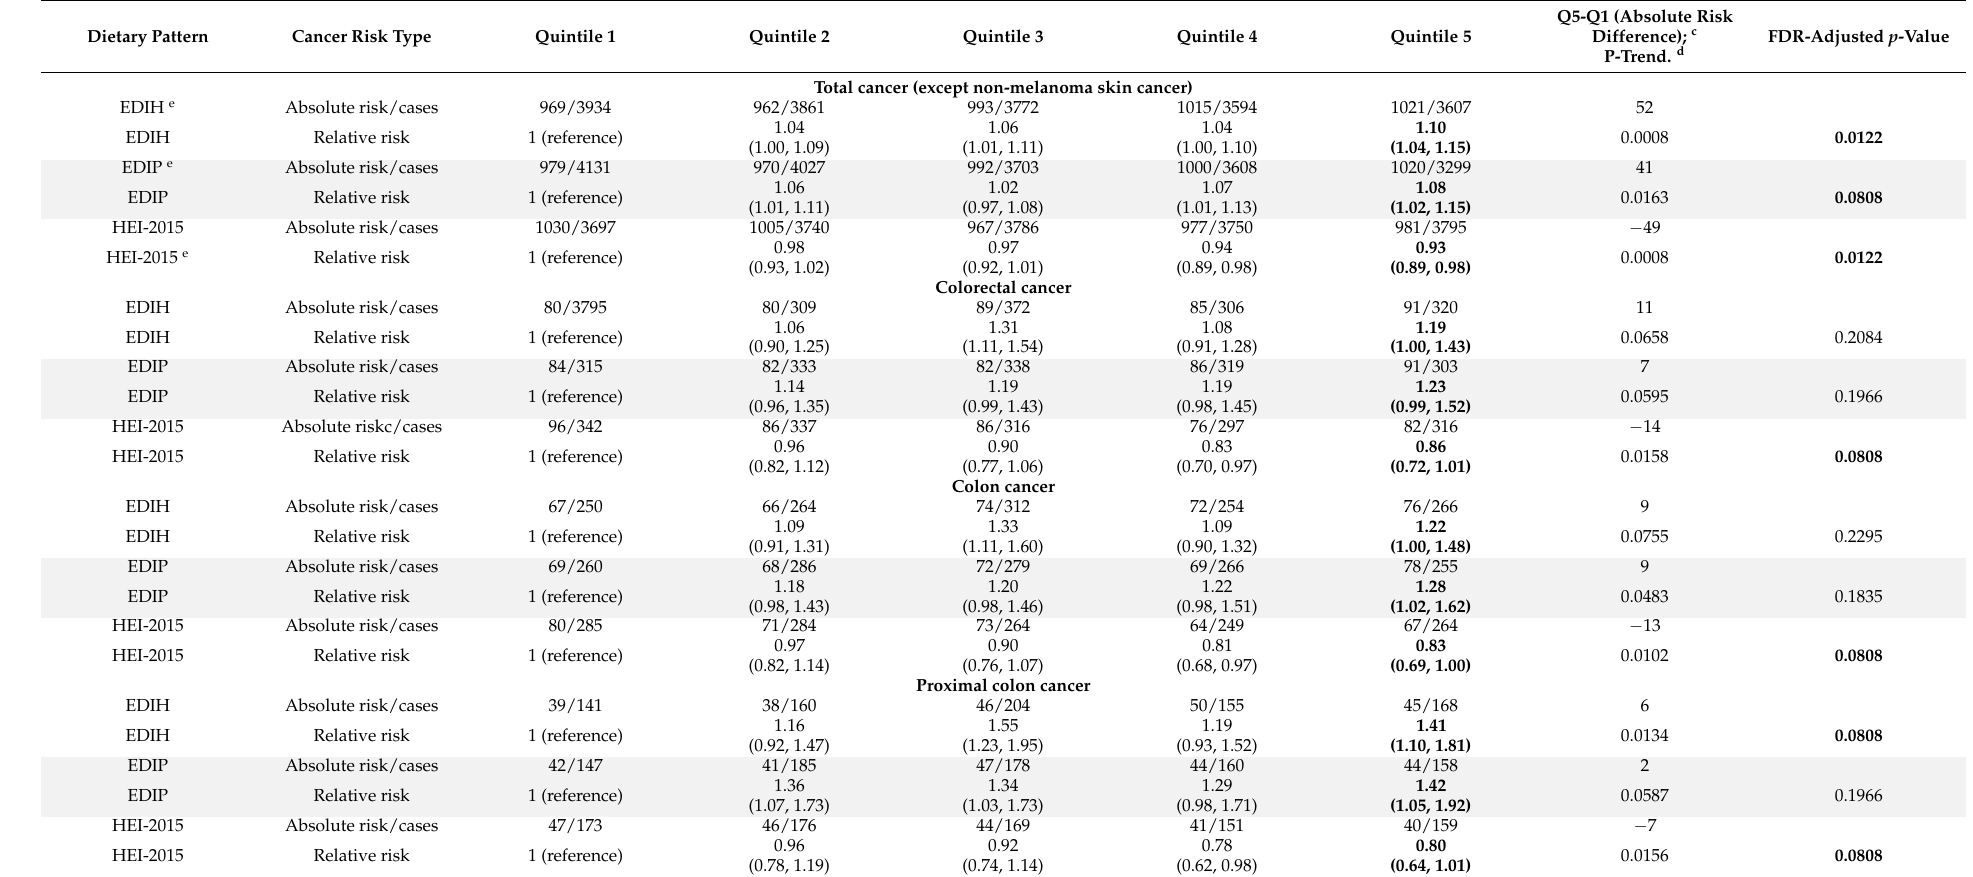
Table 2. Multivariable-adjusted absolute and relative risk for the associations of dietary patterns and future development of total cancer, site-specific cancers and pathological subtypes a,b